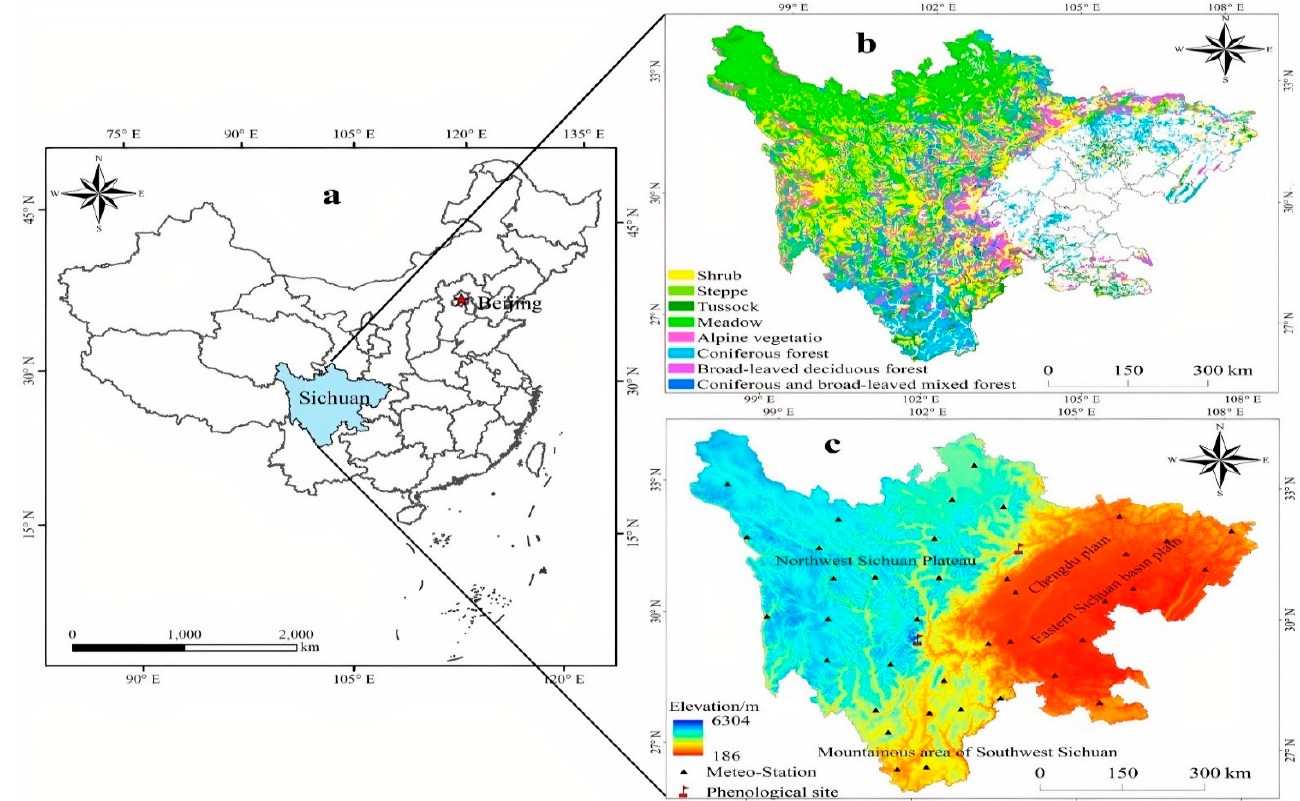
Figure 1. ( a ) The geographical position of Sichuan Province; ( b ) a map of the types of vegetation in Sichuan Province; ( c ) a topographical map and the distribution of meteorological stations in Sichuan